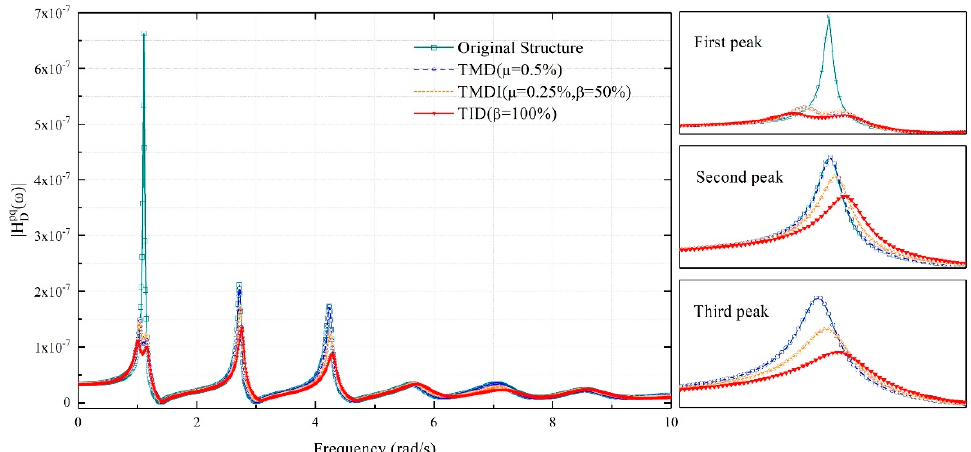
Figure 11. Displacement transfer function at top floor for different structural control schemes.